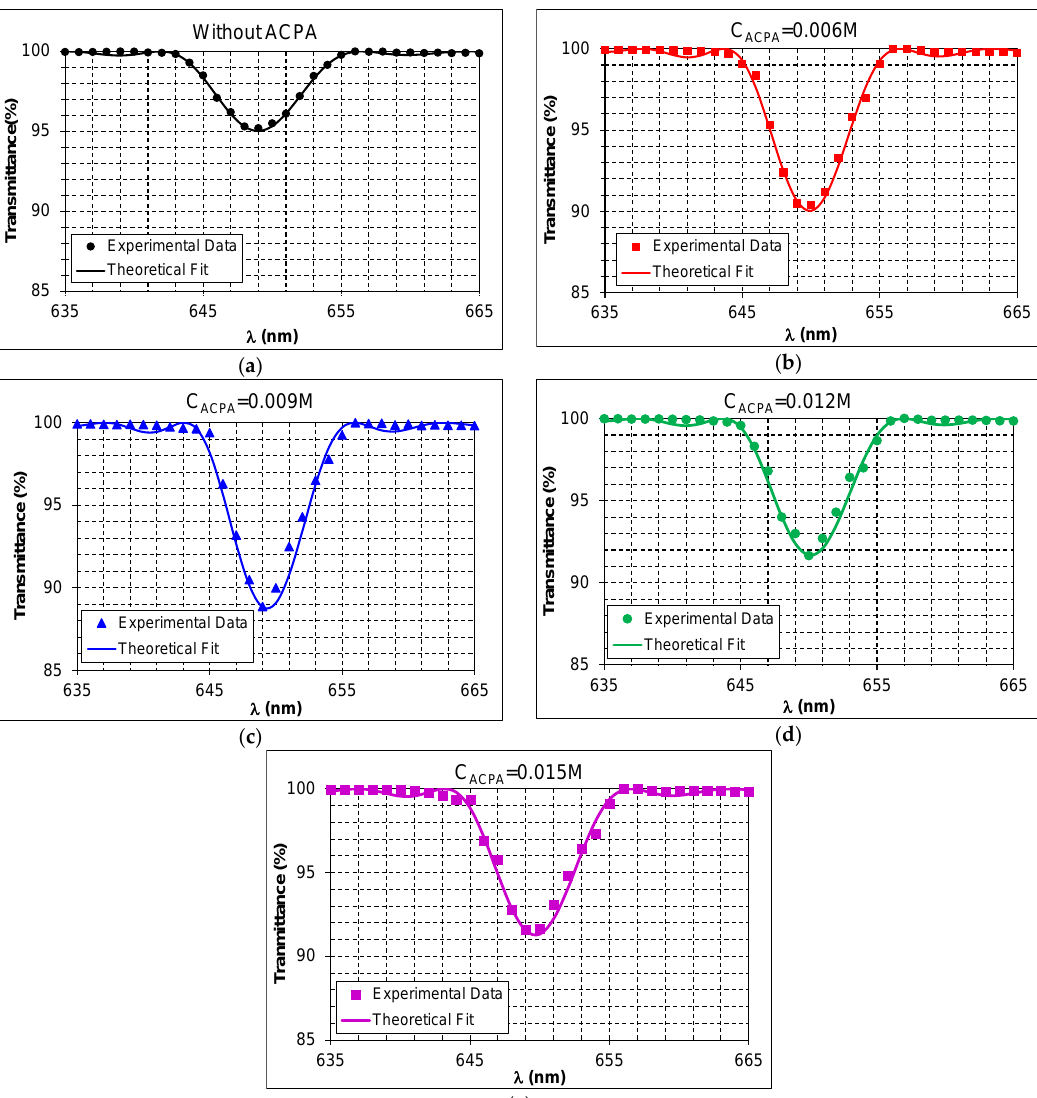
Figure 5. Transmittance as a function of reconstruction wavelength for reflection gratings stored with a spatial frequency of 4558 lines/mm for the compositions of Table 1, ( a ) C1 without ACPA; ( b ) C2 with C ACPA = 0.006 M; ( c ) C3 with C ACPA = 0.009 M; ( d ) C4 with C ACPA = 0.012 M; and ( e ) C5 with C ACPA = 0.015 M.